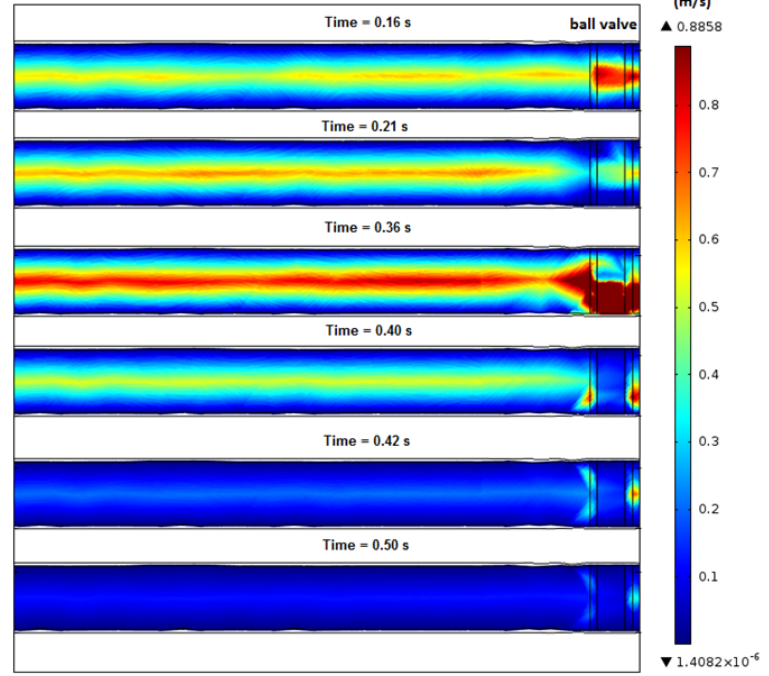
Figure 19. Velocity contours over